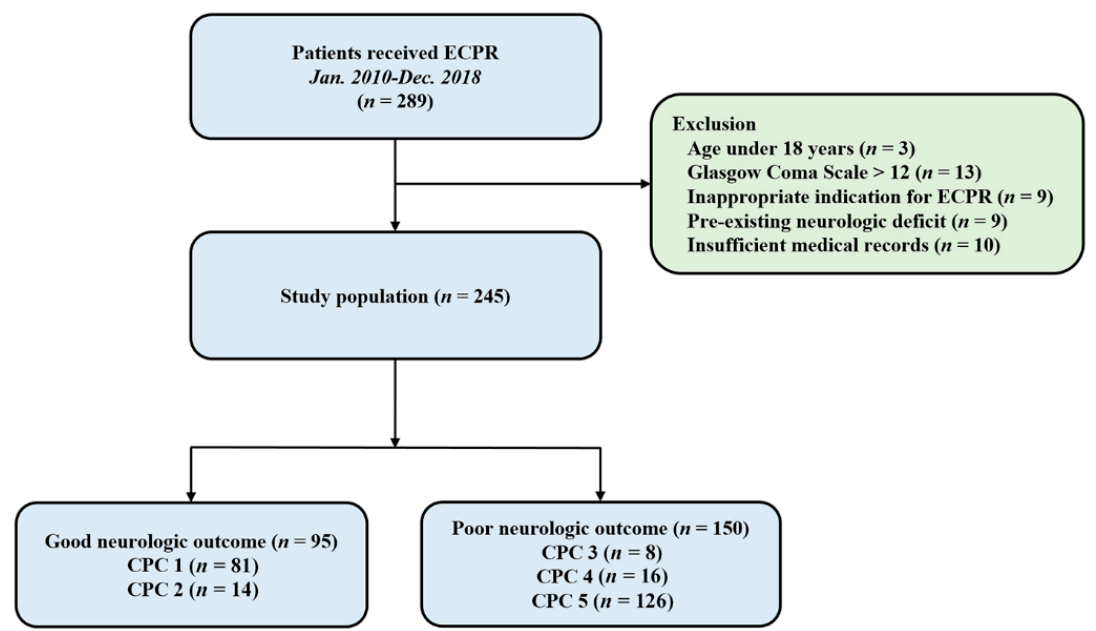
Figure 1. Study flow chart. ECPR, extracorporeal cardiopulmonary resuscitation; CPC, Cerebral Performance Categories scale.